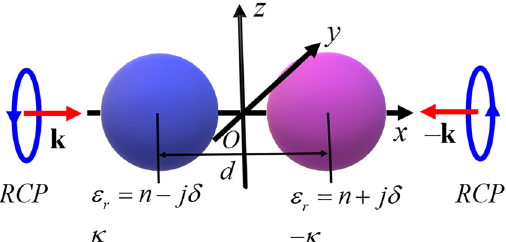
Figure 1: Two chiral nanoparticles positioned symmetrically along the x -axis to form a PT-symmetric optical scattering system. The distance between the centres of two spheres is d . The radii of two spheres are a , the relative permittivity of gain sphere is ϵ r = n − j δ with chirality parameter κ , the relative permittivity of loss sphere is ϵ = n + j δ with chirality parameter − κ . The background environ- r ment is